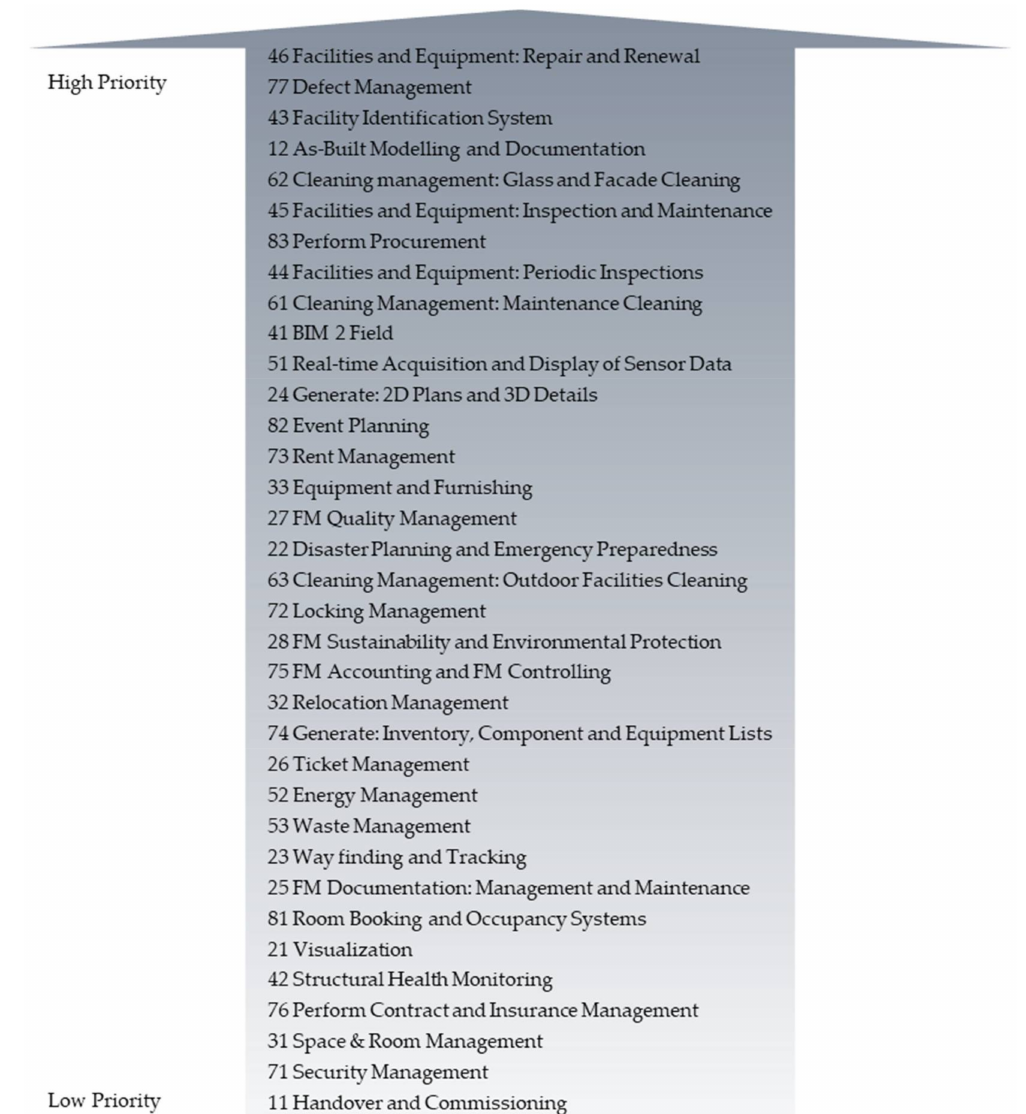
Figure 9. Prioritisation for the development of BIM uses for FM in CREM